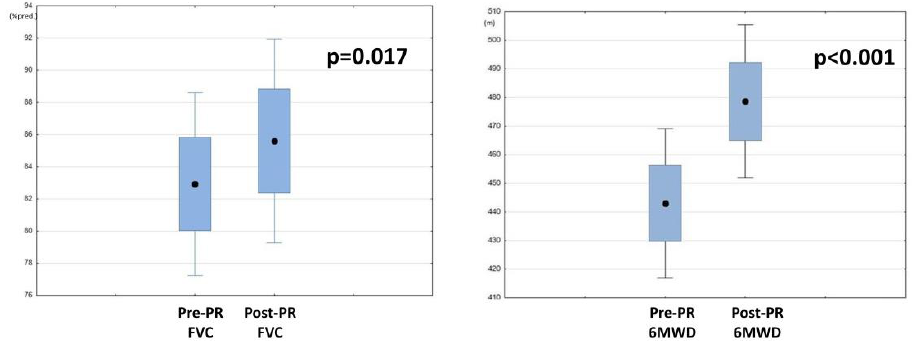
Figure 5. Changes in forced vital capacity (FVC) and 6-min walk distance (6MWD) following pulmonary rehabilitation (PR).